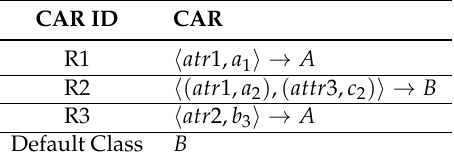
Table 8. All CARs from ECARG2.